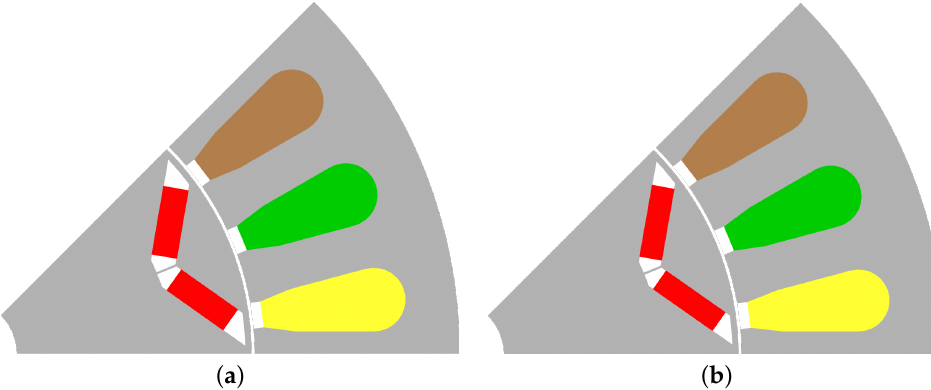
Figure 18. Cross-section of optimum designs from ( a ) multi-point method and ( b ) flux map method, all with two ECG points.